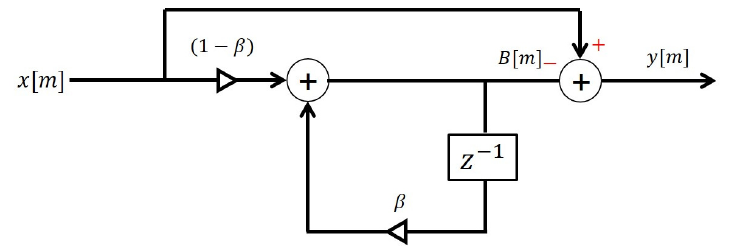
Figure 2. Structure of the running average algorithm.